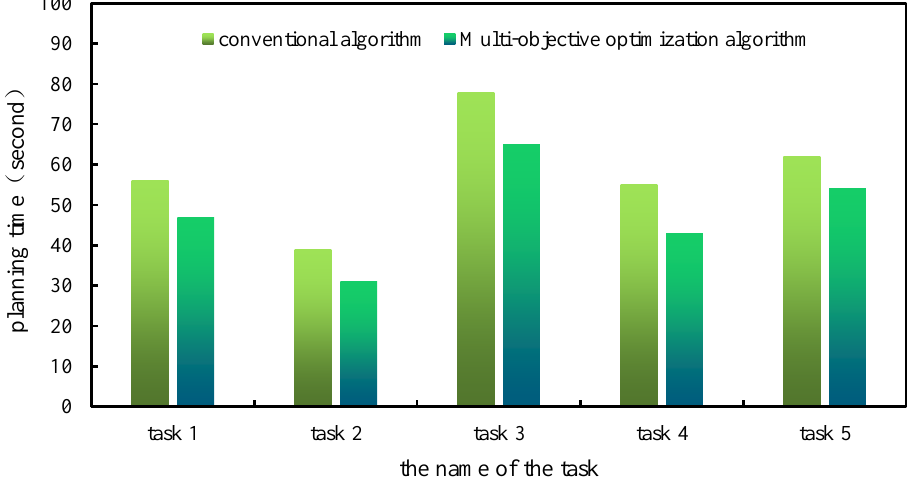
Figure 7. Time spent in UAV mission planning under the two algorithms.